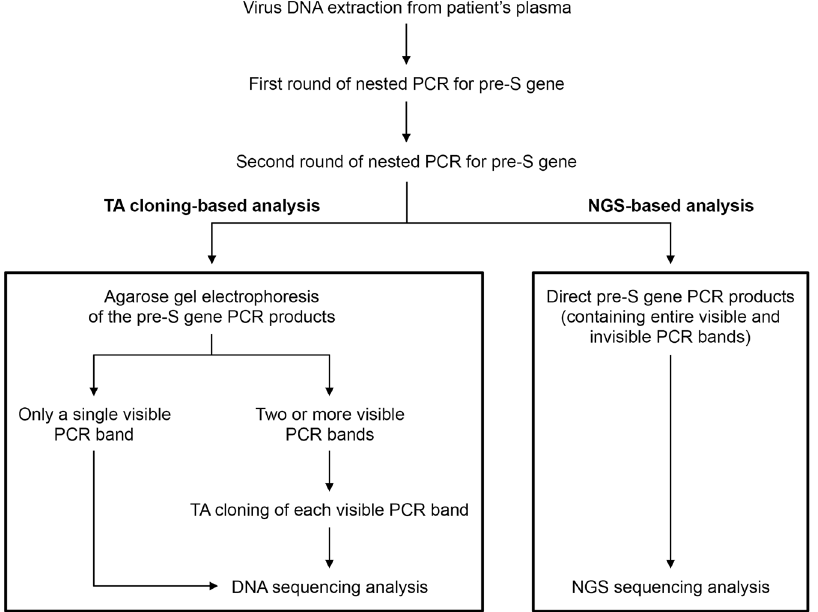
Figure 3. Flowchart of the pre-S genotyping by TA cloning- and NGS-based analysis. The virus DNA is extracted from patient’s plasma. The pre-S gene is amplified from virus DNA following first and second